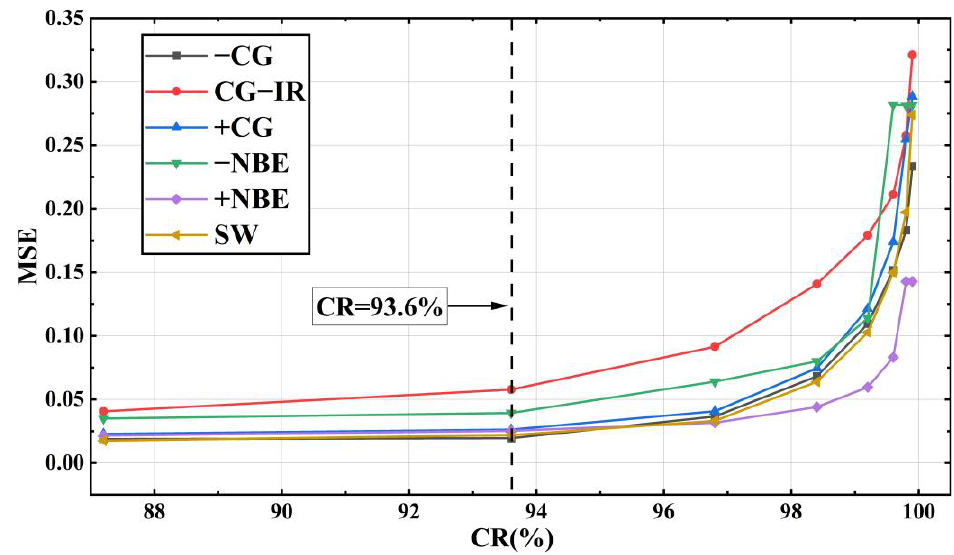
Figure 10. Comparison of original and reconstructed waveforms of LEMP at CR = 93.6%.